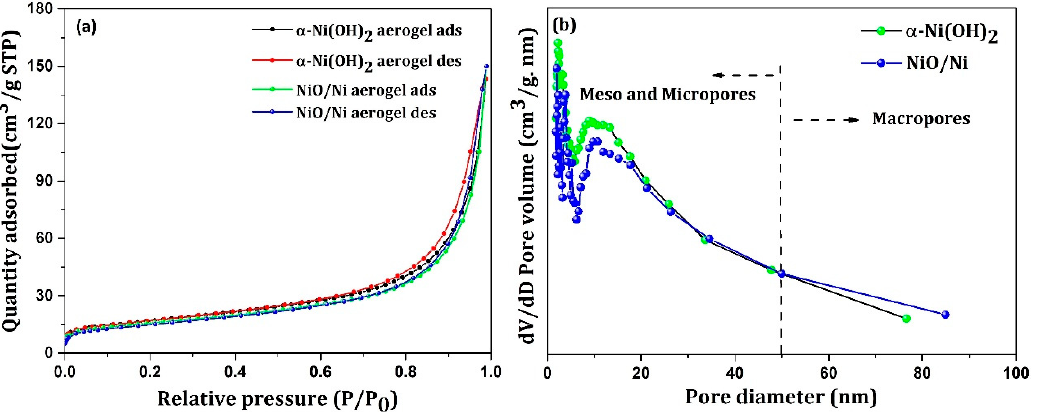
Figure 2. ( a ) N 2 adsorption–desorption isotherms and ( b ) corresponding pore size distribution plots of α -Ni(OH) 2 and NiO/Ni.